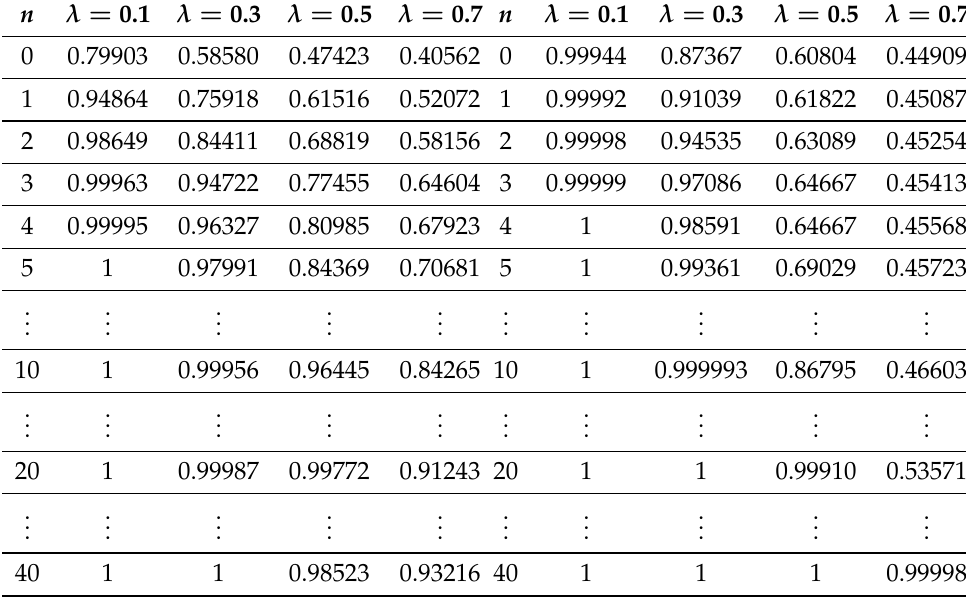
Table 2. The distribution function of the maximum queue length ¯ Q f max , n as λ varies for OTP and